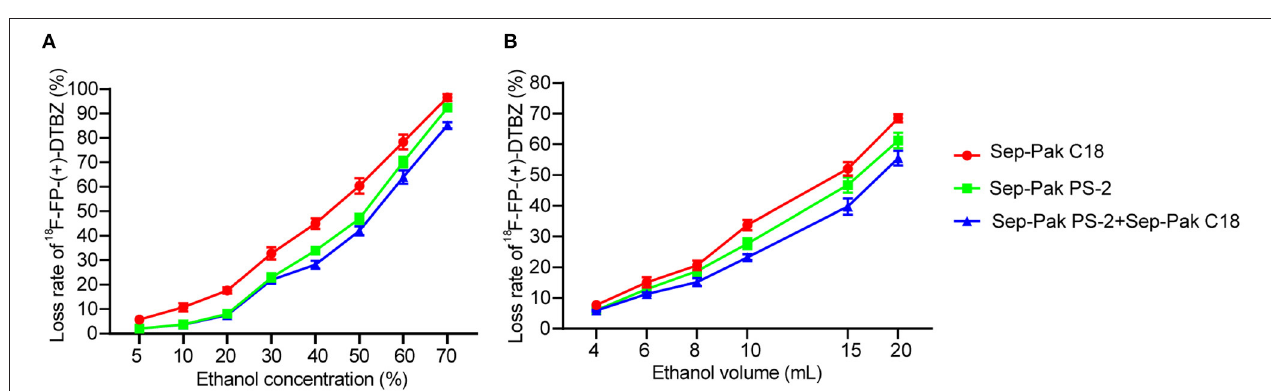
FIGURE 3 | Loss rate of 18 F-FP-( + )-DTBZ using Sep-Pak PS-2 cartridge and/or Sep-Pak C18 cartridges under different concentration of 10mL ethanol elusion (A) and different volume of 30% ethanol elusion (B) .